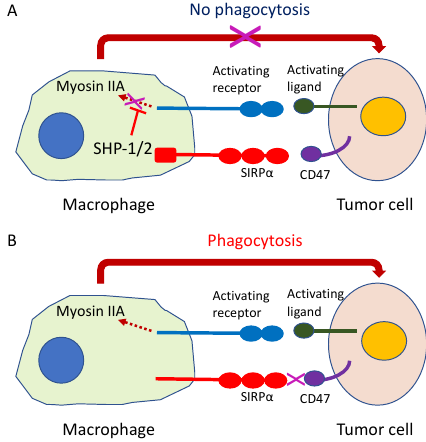
Figure 10. Innate immune checkpoint. The intercellular signal CD47-SIRPα system, formed by the signal regulating protein (SIRP) α and membranous protein CD47 located in the cell membrane of macrophages with phagocytosing capability functions as an innate immune checkpoint. ( A ) If the SIRP α on macrophage binds to CD47 on cancer cells, the cancer cells release a phagocytosis avoidance signal for macrophages to escape phagocytosis; ( B ) If this checkpoint function is inhibited, the macrophage begins tumor cell